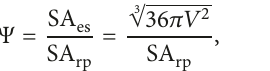
that the particles behave as individual ones [22]. In addition, the shapes of coarser particles are more irregular than that of fine particles so that the friction coefficient of coarse particle is higher, resulting in high potential to form the sand